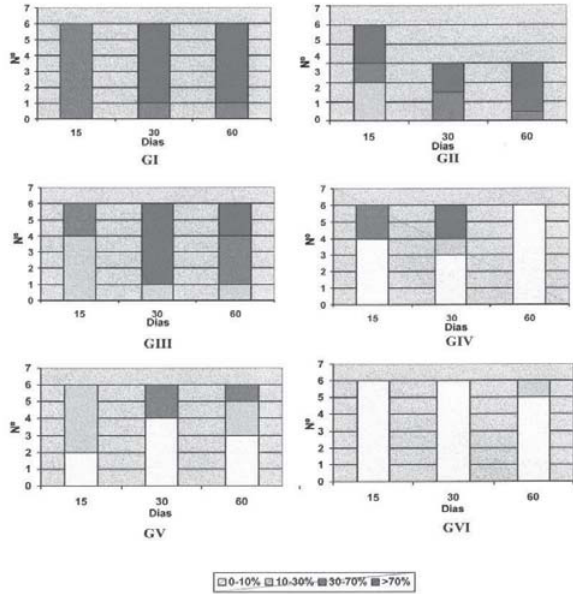
Fig. 3 – Gráficos ilustrando a distribuição do grau de calcificação distrófica de acordo com os diferentes tipos de tratamento aplicados ao segmento pericárdico e de acordo com o tempo de sacrifício dos